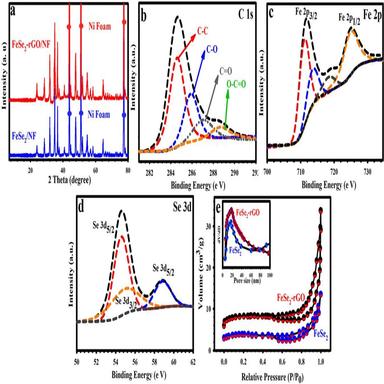
(a) XRD patterns of the FeSe2/NF and FeSe2-rGO/NF electrodes. (b) High-resolution XPS spectrum of C 1s of the FeSe2-rGO/NF. (c) High-resolution XPS spectrum of Fe 2p of the FeSe2-rGO/NF. (d) High-resolution XPS spectrum of Se 3d of the FeSe2-rGO/NF. (e) N2 adsorption/desorption isotherm of the FeSe2 and FeSe2-rGO and their corresponding BJH pore size distribution curves (inset).